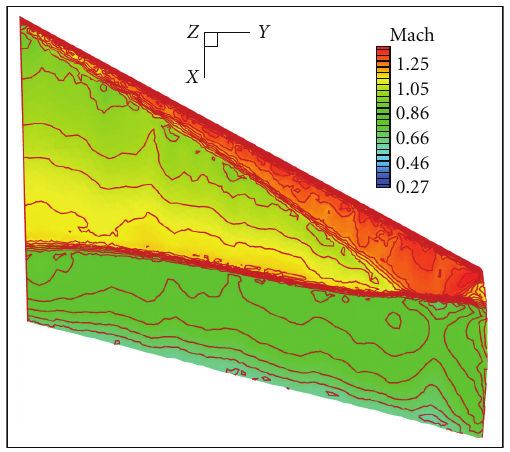
Figure 6: Mach contours on adapted surface of ONERA M6 wing at M ∞ = 0 . 8395 and α = 3 . 06 ◦